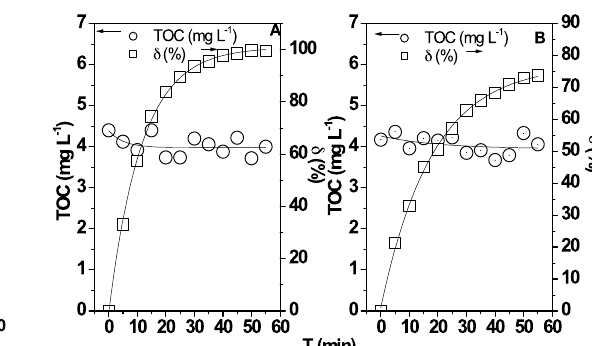
Figure 3. The degradation of 0.050 mmol L -1 ACBK with controlled Cu 2+ concentrations (0.000, 0.0025, 0.0050, 0.0100, 0.0200, 0.0300 and 0.0400 mmol L -1 ) at pH 5.0 buffer solution with 0.05% P25 TIO at different times.